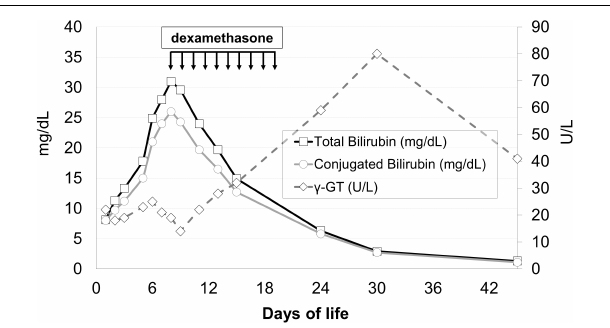
FIGURE 1 | Total bilirubin, conjugated bilirubin, and γ -GT levels before and after steroid treatment. The arrows indicate the timing of steroid